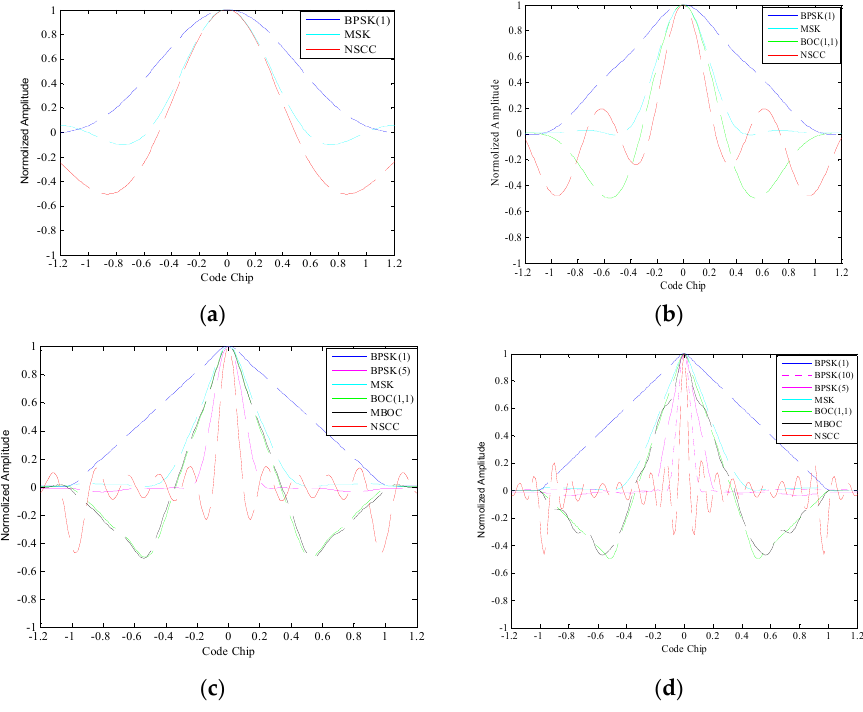
Figure 3. ACFs for NSCC modulation and legacy navigation modulations with: ( a ) 2 MHz, ( b ) 4 MHz, ( c ) 10 MHz, ( d ) 20 MHz pre-filtering bandwidths.